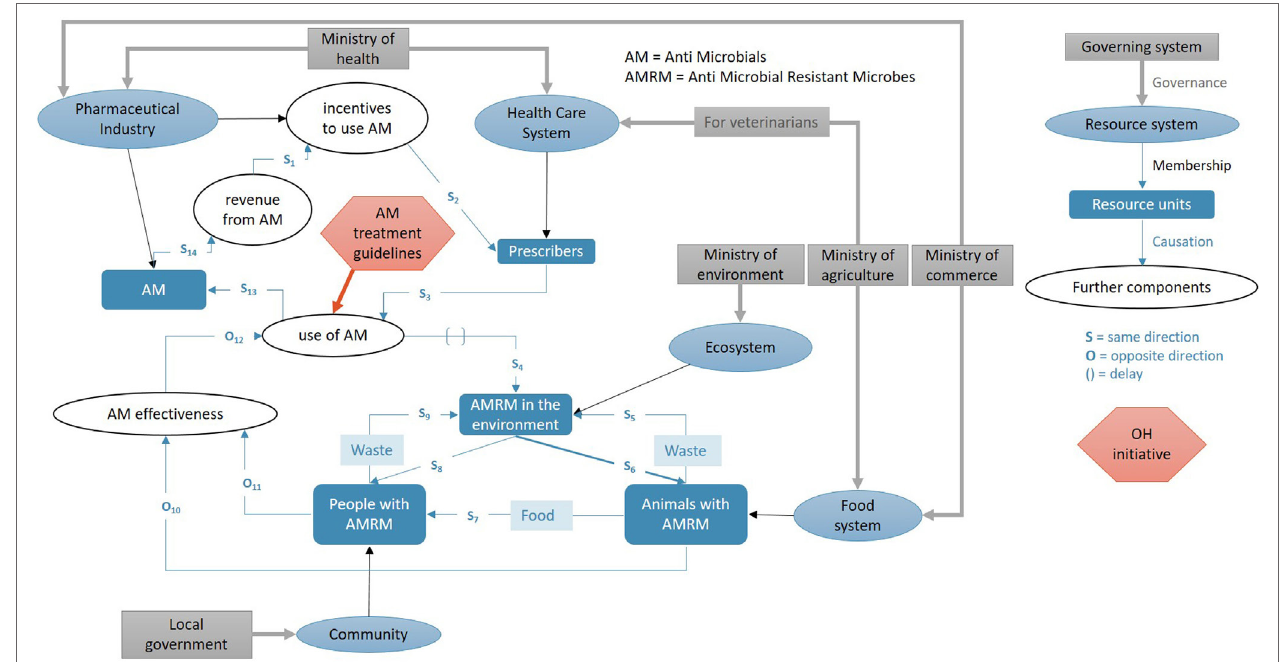
FIgURe 2 | Example for visual representation of an initiative in its context exemplified by occurrence of antimicrobial resistance within a given system: resource systems (blue ovals), resource units (dark blue boxes), and governance systems (grey boxes) within which an initiative operates. Furthermore, tangible and intangible components (white ovals) are included. Relationships (arrows) are classified as governance (grey), membership (black), and causal interactions (blue) with explanatory text (light blue boxes). Letters designate changes of two components in the same (S) or opposite (O) direction, respectively. The red hexagon represents the initiative with arrows where it impacts the